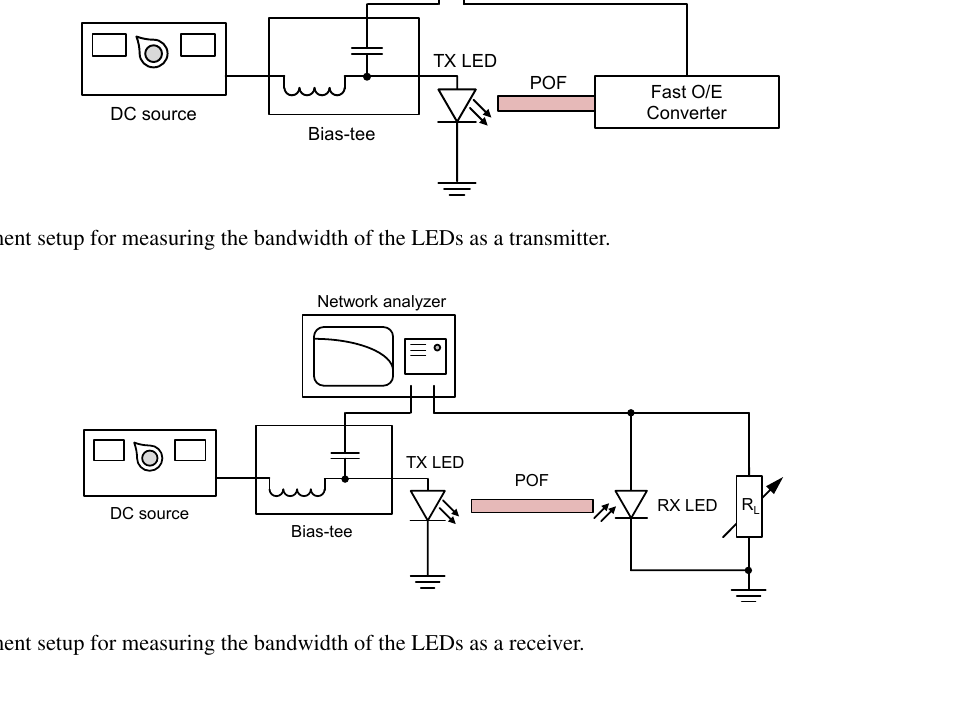
4 Sensor network